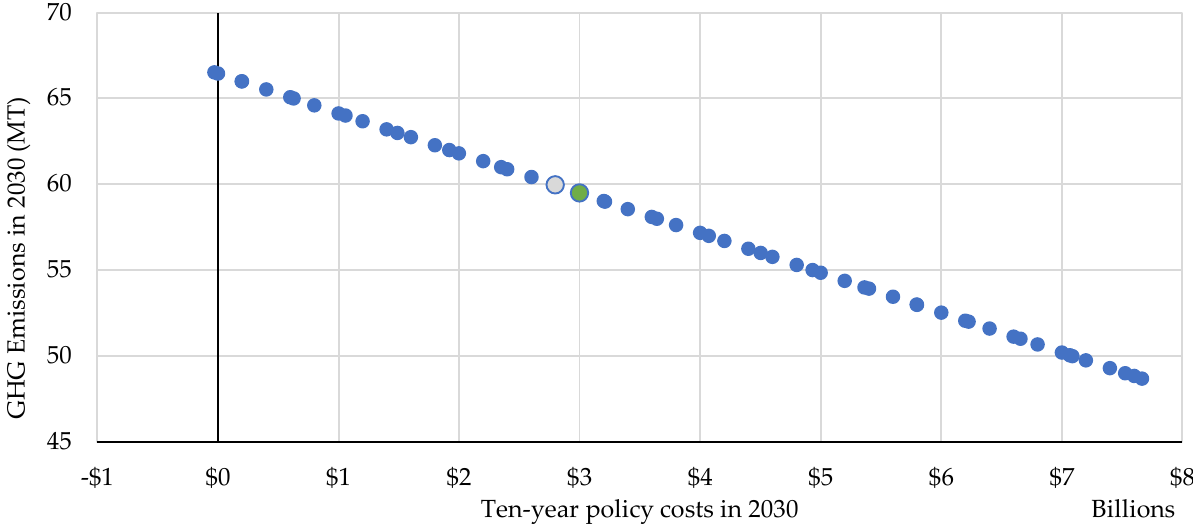
Figure A1. Pareto front 1 calculated from the MIO model. Assumes LDV fleet is 38% EV in 2030 (high-EV) and upper-bound TCO (high-TCO). Green and grey points represent the two policy scenarios (~3$ billion ten-year policy costs in 2030 and 40% GHG reduction relative to 2005 levels in year 2030) presented in Section 4.